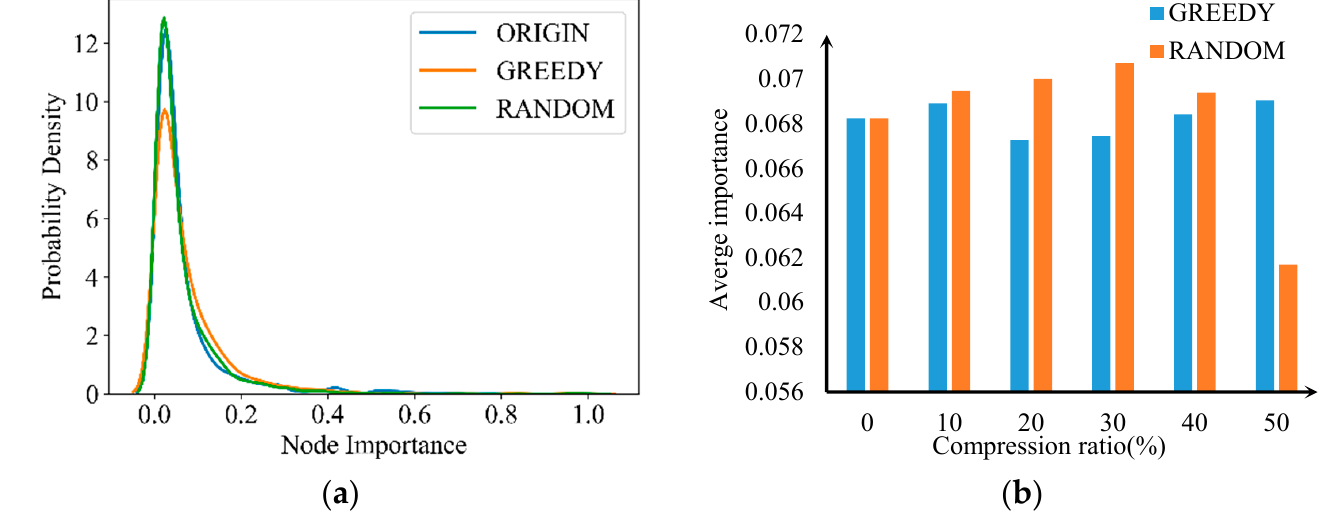
Figure 2. Importance metrics of graph summarization. ( a ) Node importance probability density distribution of graph summary. ( b ) Average node importance with compression ratio.